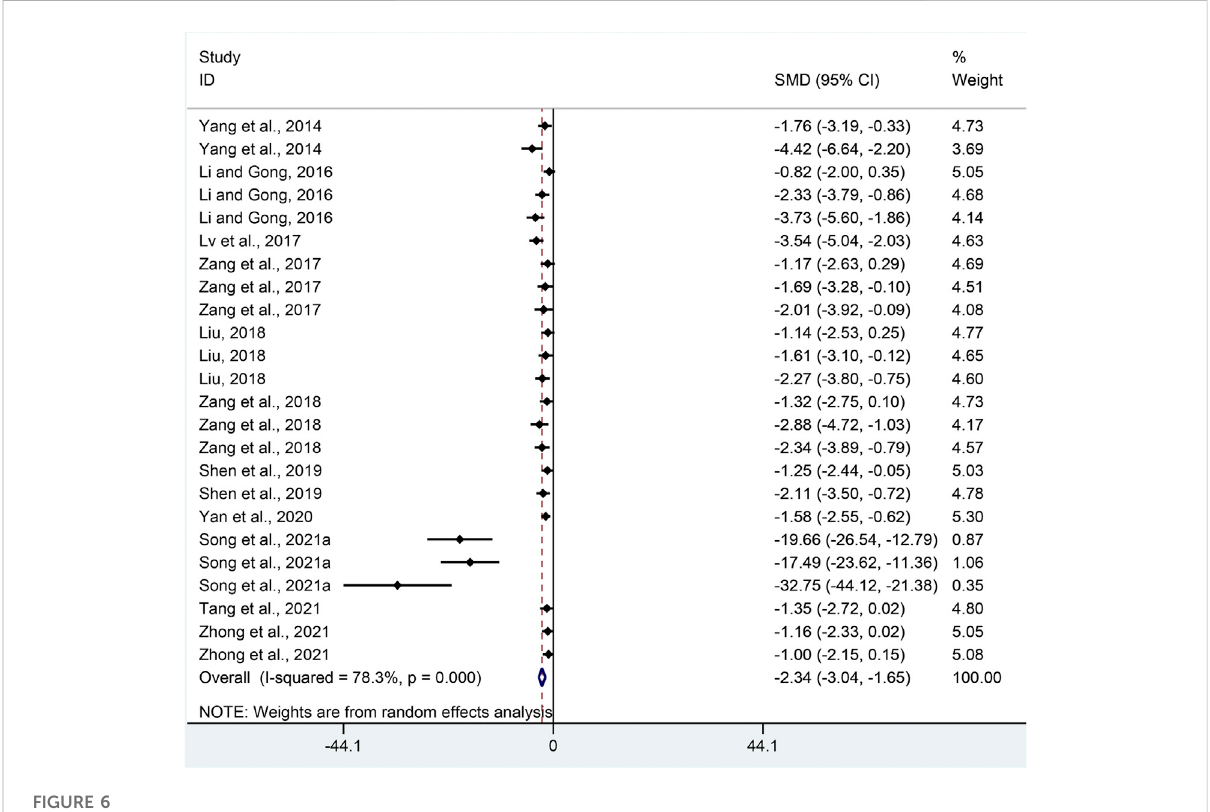
FIGURE 6 Pooled estimate of TNF- α with